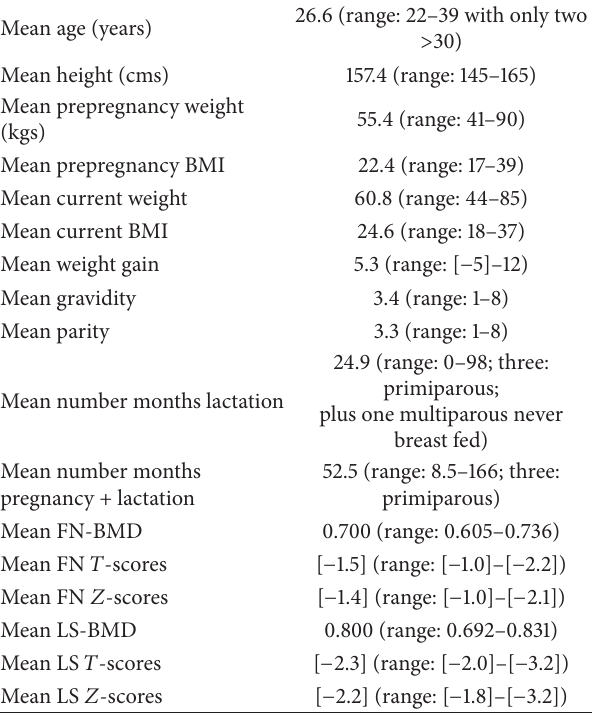
Table 6: Results in 12 outliers based on 𝑇 -scores and/or 𝑍 -scores <− 2.0 at the